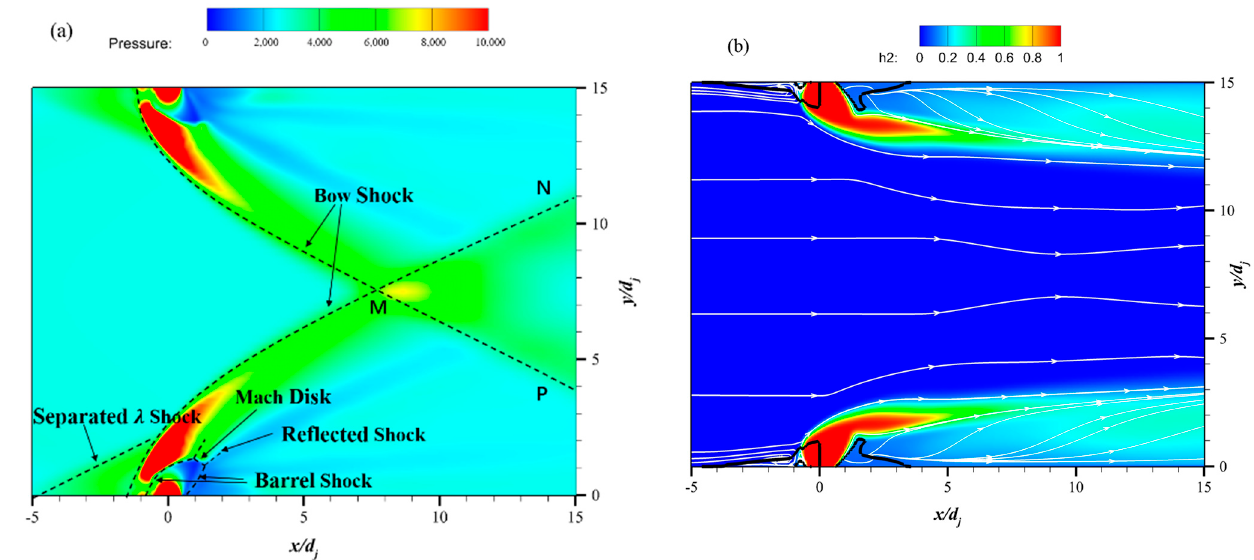
Figure 7. Diagram near jet at z = 0 ( a ) pressure contour. Shock waves are signed in black. ( b ) hydrogen mass fraction contour and contour line with the flow velocity of 0.